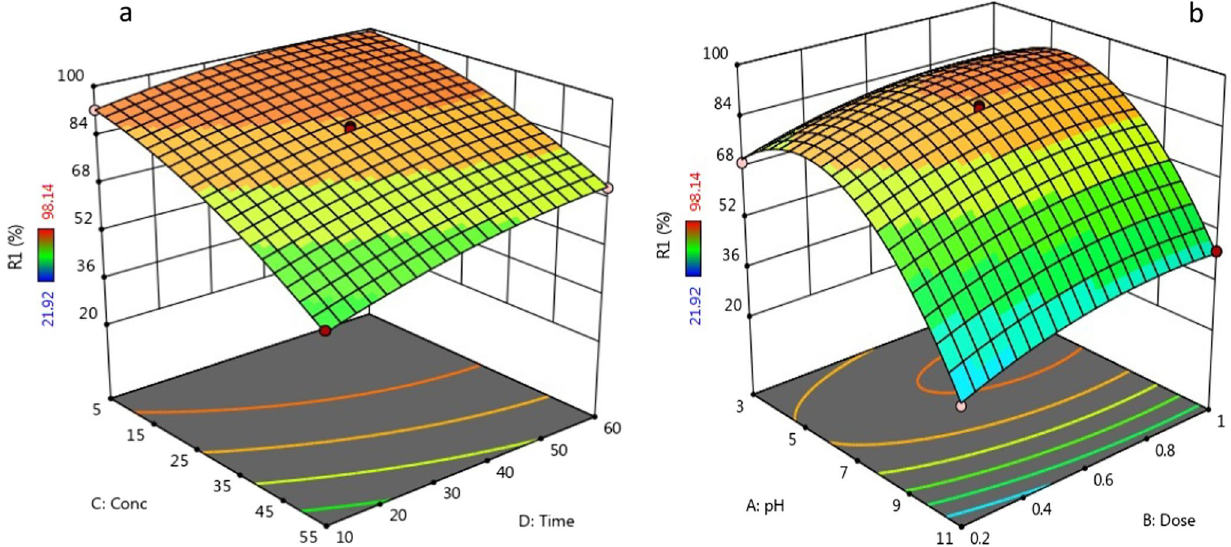
Fig. 6 Effect of changes in variables on DZN adsorption efficiency: a Nanocomposite and pH value (initial concentration of 30 mg/L, contact time 35 min), b initial concentration and contact time (pH = 7, nanocomposite value = 0.6